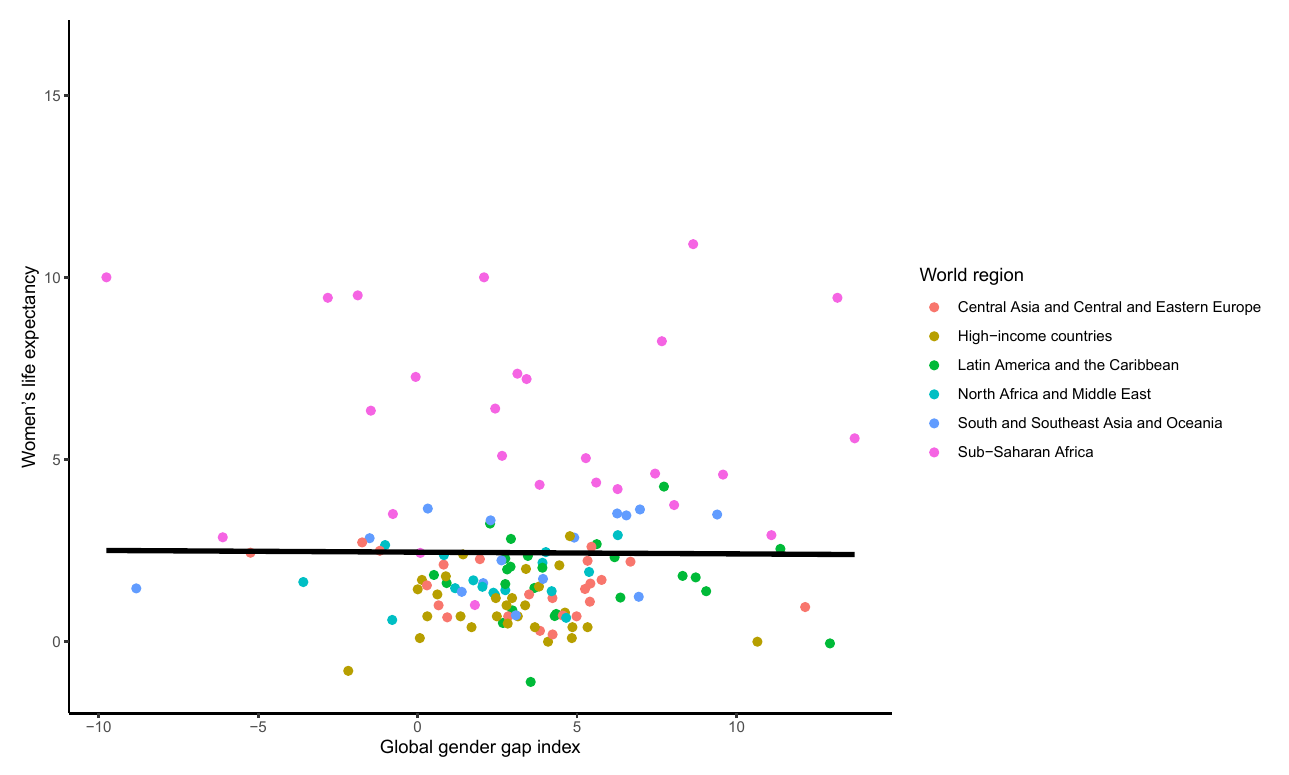
Fig 3. Association between change in the mGGGI and change in women’s life expectancy between 2010 and 2020. The scatterplot displays the linear regression line for the association between the change in the mGGGI and the change in women’s life expectancy (-0.05 [-0.95 to 0.85], p-value 0.913).